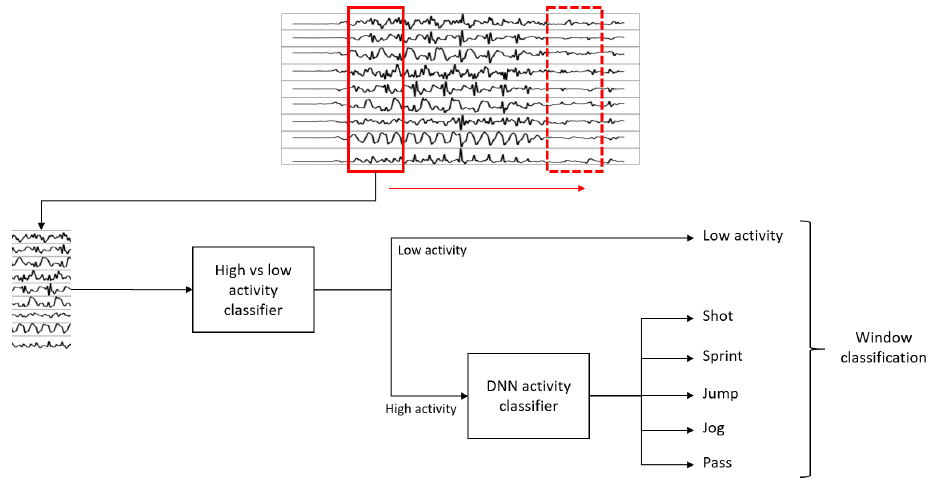
Figure 13. Sliding window evaluation diagram.